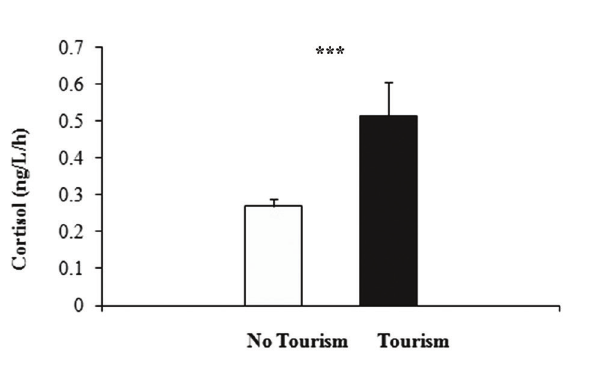
Fig. 9. Variation (mean and SEM) of cortisol responses to restraining stress in Moenkhausia bonita individuals at the No Tourism and Tourism sites (Mann-Whitney U-test, N = 6; Z = -2.95; p <